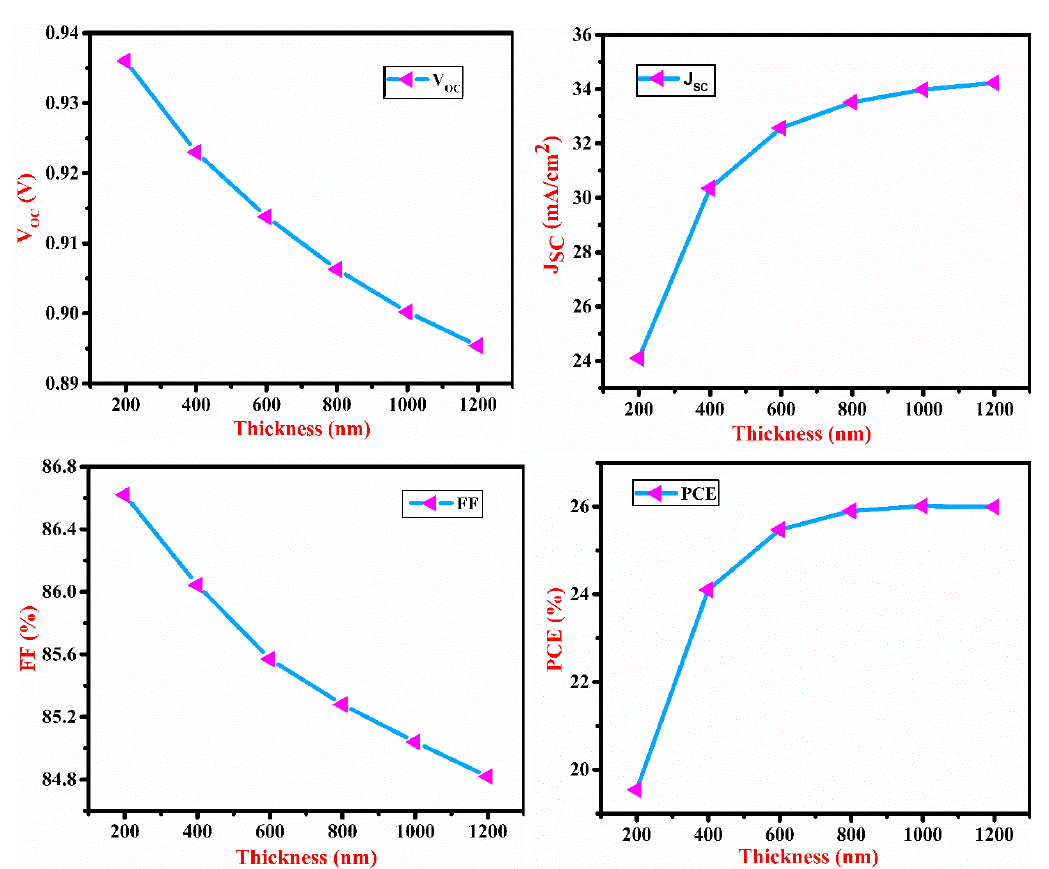
Figure 4. Impact of SnS layer thickness on V OC , J SC , FF and PCE of the proposed